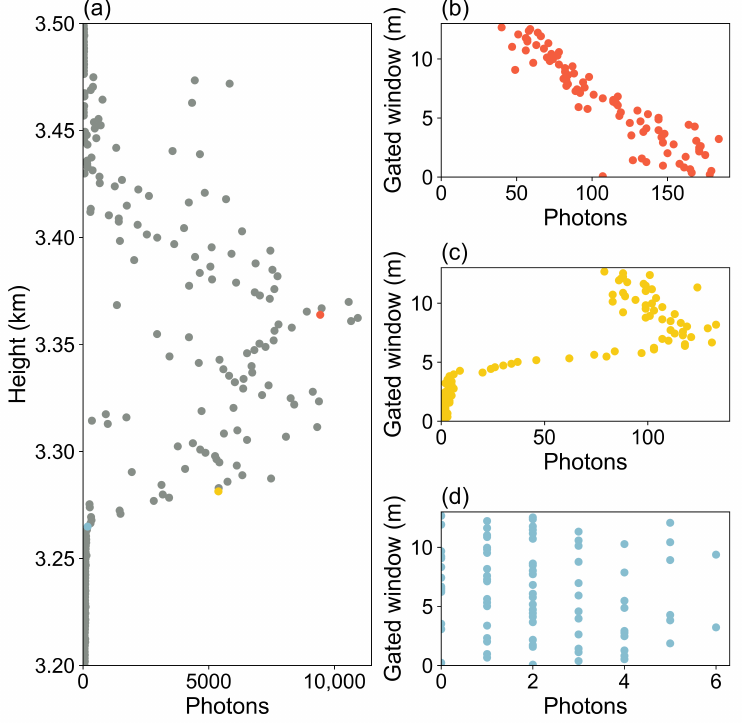
Figure 6. ( a ) Profiles of photons received with the vertically pointing T2 lidar operating in time-gated mode. Each point represents the number of photons received from a specific height in an 80 ns gated window (corresponding to 12 m) within 1 s. The subpanels on the right show the distribution of photons received within three selected gated windows at the locations given in ( a ) by colored points coded to match the color used in each subpanel: ( b ) inside the cloud (red), ( c ) at the cloud base (yellow), and ( d ) below the cloud base (blue). The arrival times of photons within each gated window were binned to 1 ns, corresponding to 15 cm range